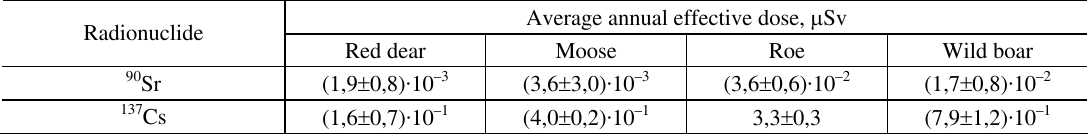
Fig 1. Average activity concentrations of 90 Sr and 137 Cs measured in samples of meat of game in Lithuania during two hunting seasons in 2003–2005, Bq/kg of fresh weight Table 2. Average annual effective dose due to 90 Sr and 137 Cs in samples of meat of game hunted in 2003–2005, µ